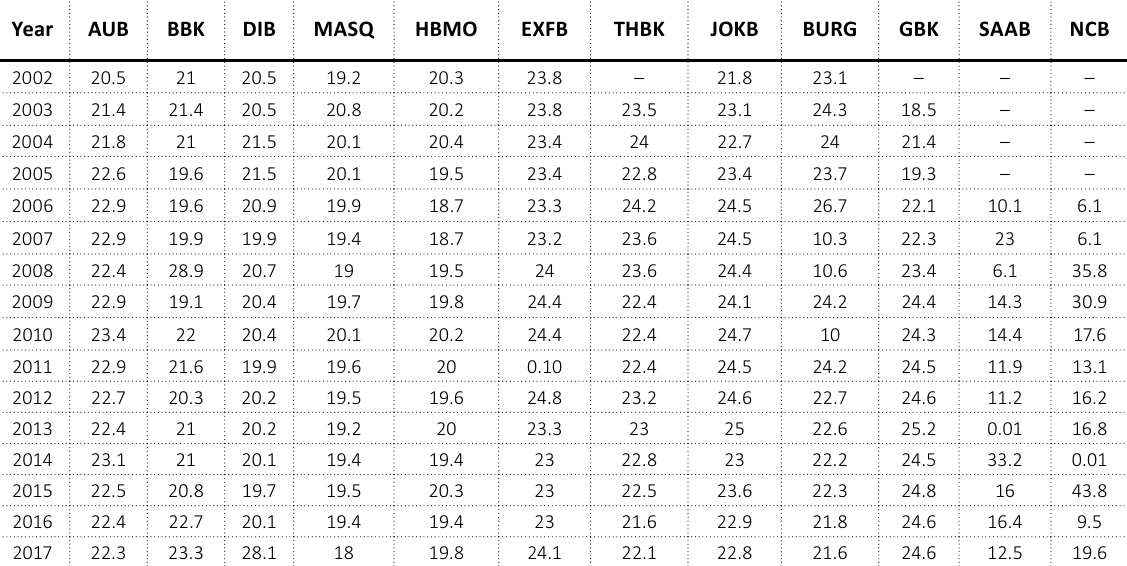
Table 2. The percentage of overall emotional words in banks’ annual reports (from 2002 to